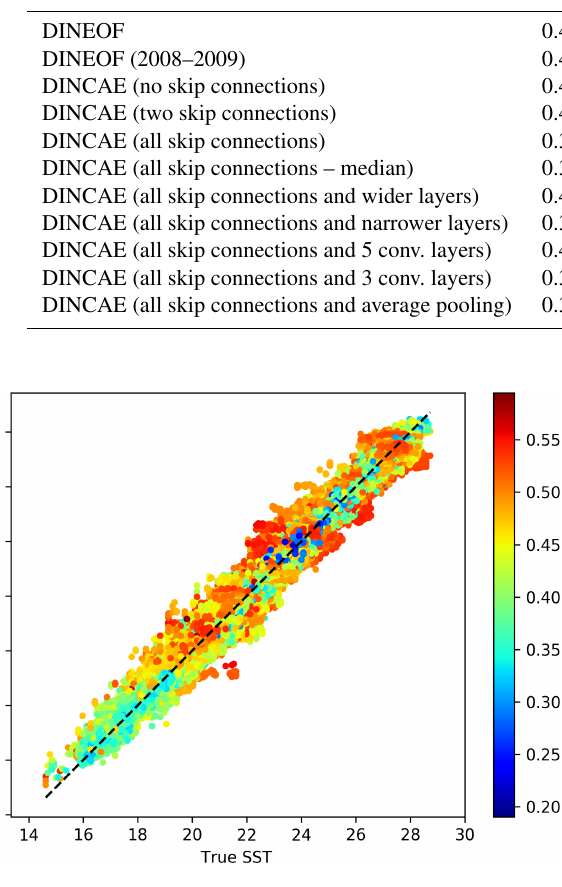
Figure 4. The original SST versus the reconstructed SST for the cross-validation dataset. The color represents the estimated ex- pected error standard deviation.